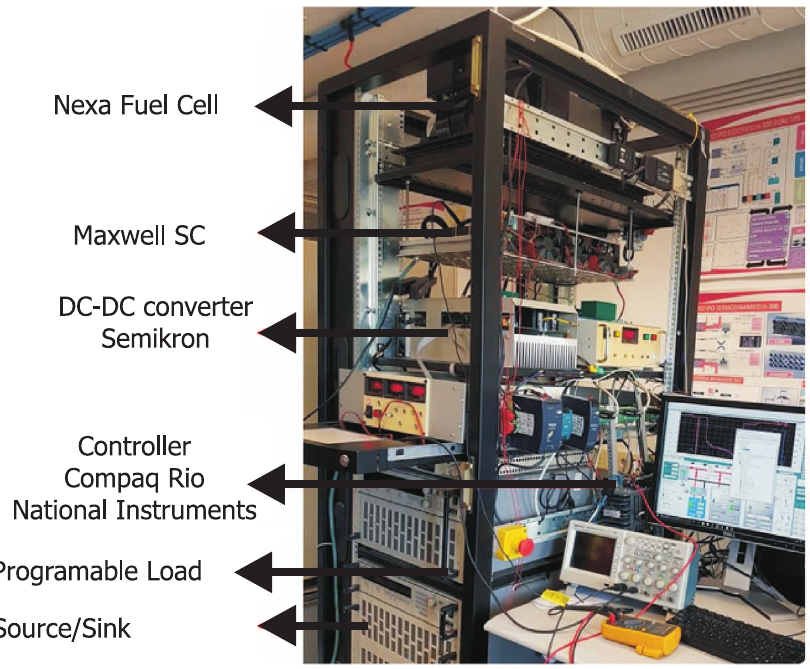
Figure 7. Fuel cell test station in the laboratory of